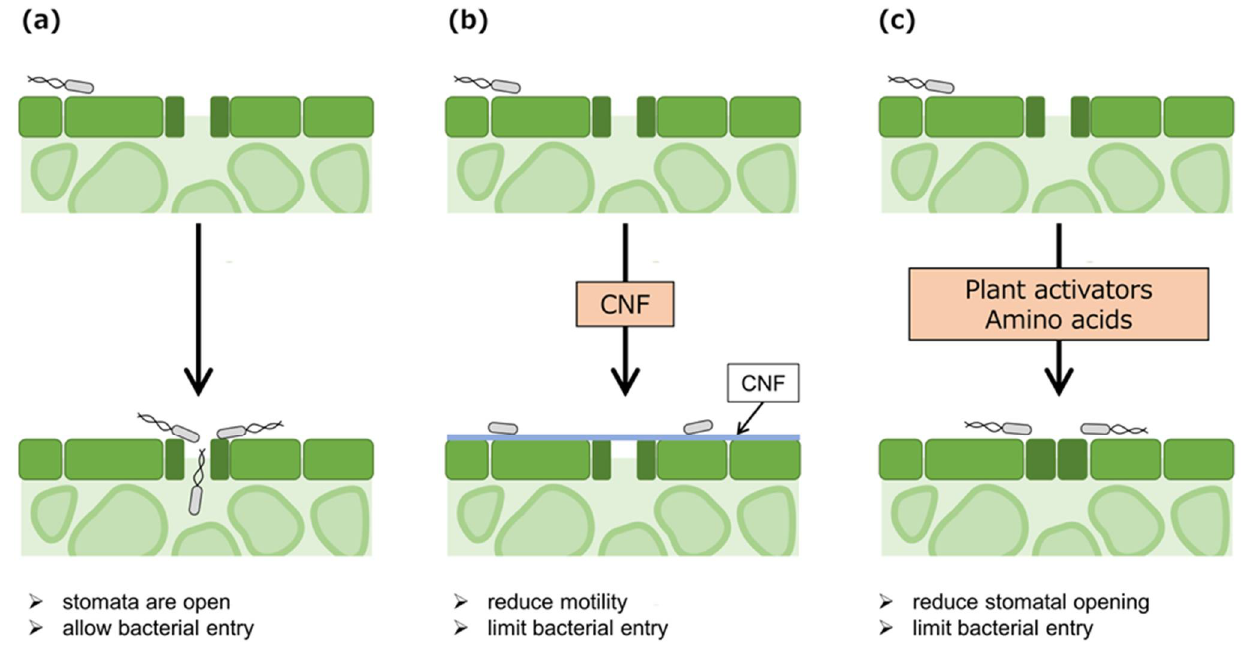
Figure 2. A diagram describing successful and failed entry into plants. ( a ) Bacteria overcome stomatal-based defense by using phytotoxins and type 3 effectors, resulting in successful entry. ( b ) Covering the leaf surface with cellulose nanofibers (CNFs) leads to motility reduction, limiting bacterial entry. ( c ) Plant activators (e.g., acibenzolar- S -methyl and probenazole) and amino acids (e.g., cysteine, glutamic acid, and lysine) lead to a reduction in stomatal aperture, limiting bacterial entry.